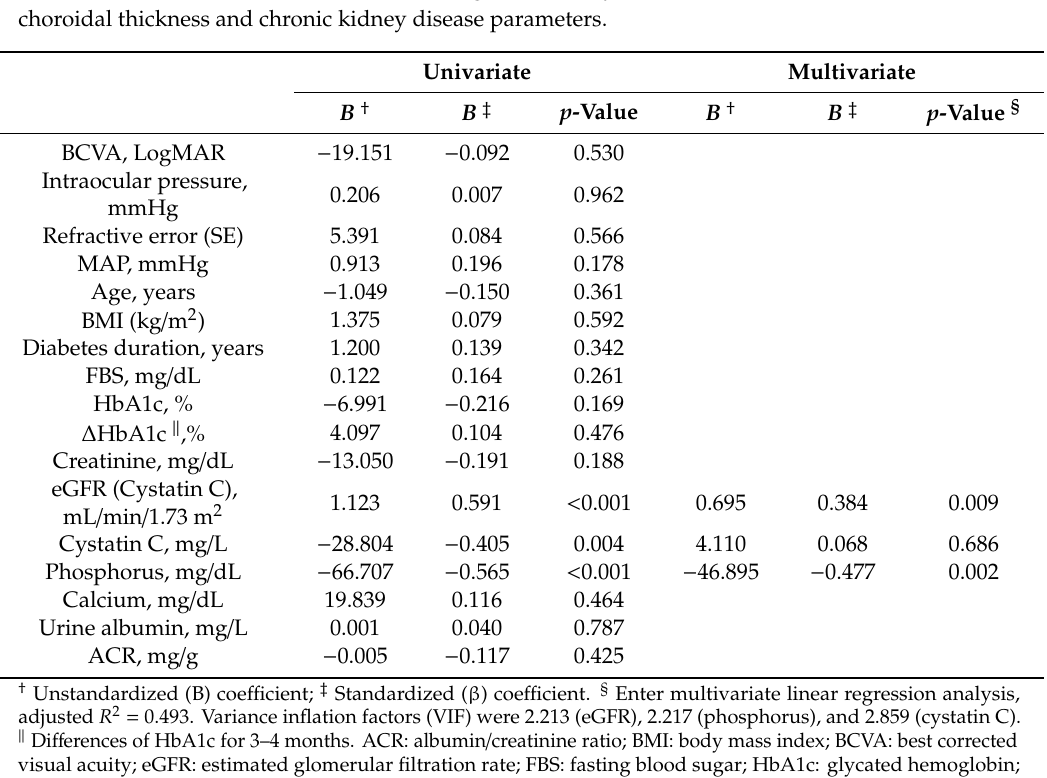
Table 3. Univariate and multivariate linear regression analyses of the association between subfoveal choroidal thickness and chronic kidney disease parameters.